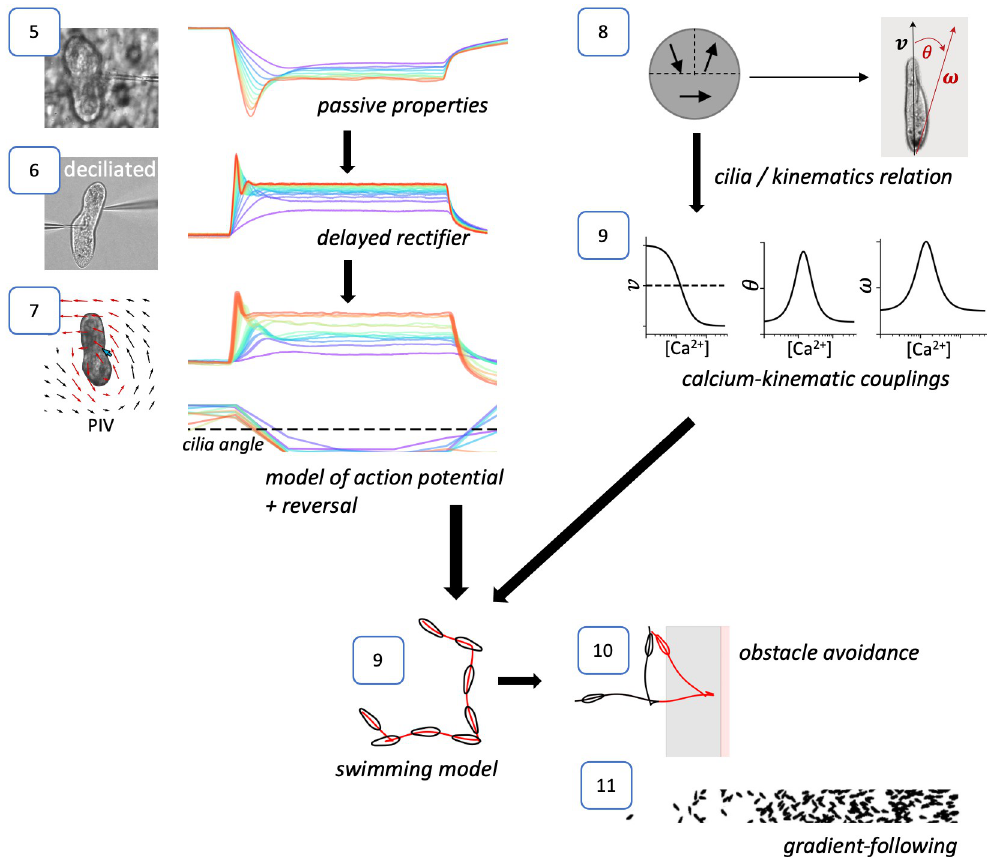
Fig 4. Outline of the modeling strategy. Each number indicates the corresponding figure. The left column (5–7) is the electrophysiological modeling. The right column (8–9) is the modeling of couplings between electrophysiology and kinematic variables. Put together, we obtain a model of a freely swimming Paramecium (9), which is then augmented with elementary sensory transduction models to yield model simulations in structured environments